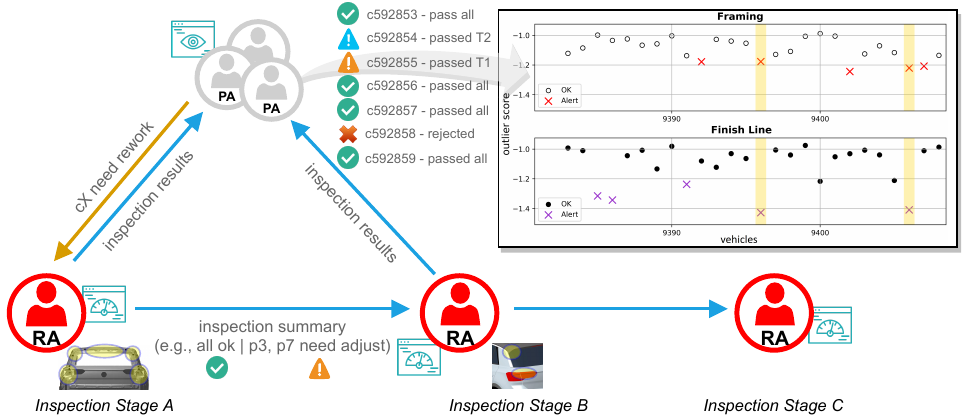
Figure 9. Interactions among agents to support the detection of abnormalities during inspection of the assembly process at the body shop